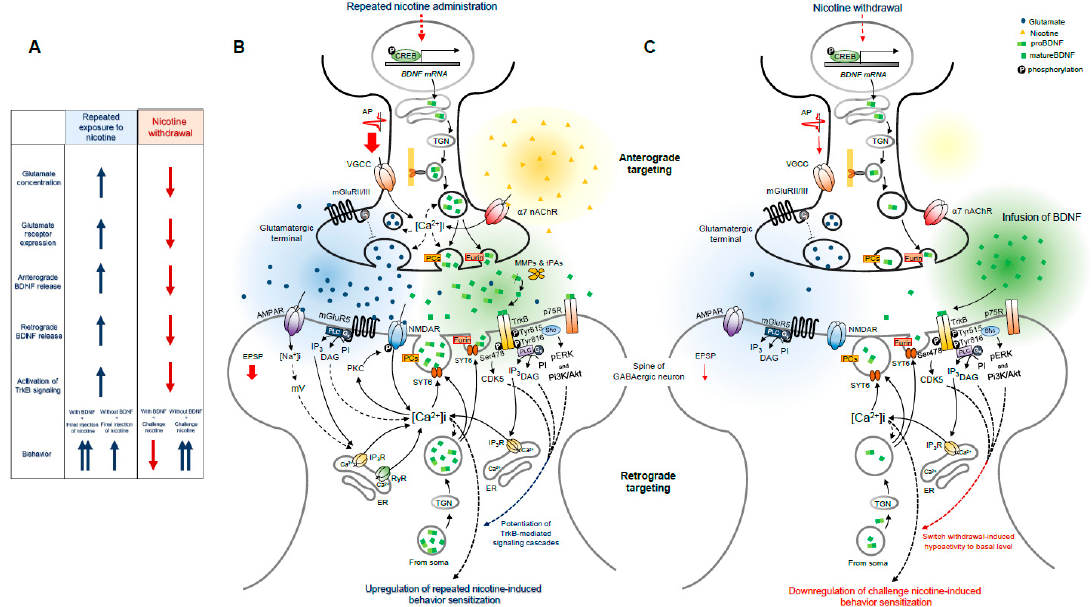
Figure 1. ( A ) Changes in glutamatergic neurotransmission, bidirectional BDNF release, BDNF-mediated signaling cascades, and behavioral sensitization after repeated exposure to nicotine and nicotine withdrawal. ( B , C ) Proposed cellular mechanisms underlying repeated nicotine exposure and nicotine withdrawal mediated e ff ects in GABAergic neurons are schematically depicted and compared. Exogenous BDNF infusion into the striatum during nicotine withdrawal returned hypoactivated GABAergic neurons to the basal level by activating TrkB-linked signaling cascades [91,96,97]. Switched neural activity caused by BDNF does not alter after challenge nicotine administration. Putative interactions are discussed in the text. Solid and broken arrows represent direct and indirect stimulations of downstream molecules or behaviors, respectively. AP, action potential; [Ca 2 + ], Ca 2 + concentration; EPSP, excitatory postsynaptic potential; IP 3 R, inositol trisphosphate receptor; mV, membrane potential; [Na + ], Na + concentration; PKC, protein kinase C; RyR, ryanodine receptor; SYT, synpatotagamin; tPAs, tissue-plasminogen activators; VGCC, voltage- gated calcium channel.